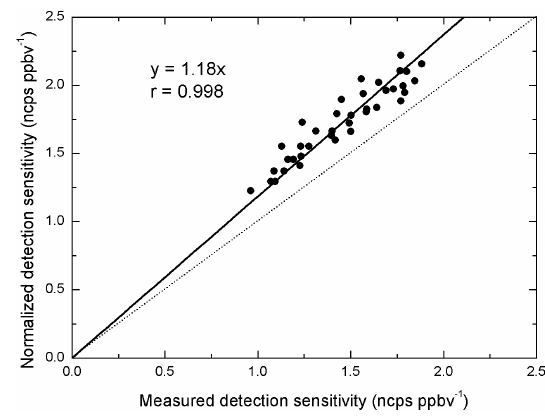
Figure 8. Linear regression of the measured detection sensitivity of HCHO and its normalized detection sensitivity by water vapor concentration in sample